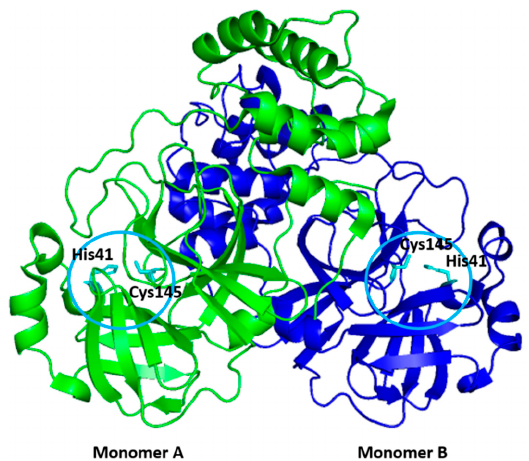
Figure 2. The dimer structure of SARS-CoV-2 3CLpro. Two monomers were indicated by different colour for clarity. The catalytic residues of Cys145 and His41 of each monomer (indicated by circles) are shown in stick (cyan).